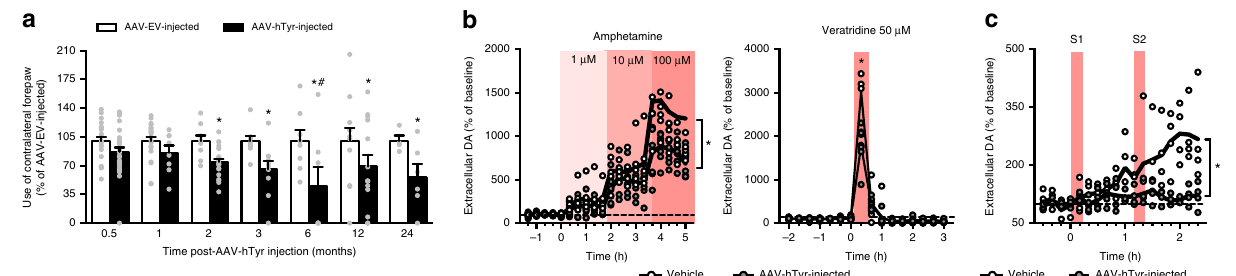
Fig. 4 Early dopaminergic dysfunction in AAV-hTyr-injected rats. a Contralateral forepaw use in AAV-hTyr- and AAV-EV-injected rats, as assessed with the cylinder test. * p ≤ 0.05, compared to AAV-EV-injected animals at the same time-point; # p < 0.05, compared to 0.5 m AAV-hTyr animals (two-way ANOVA; Student – Newman – Keuls post-hoc test). b Striatal DA release in AAV-hTyr- and vehicle-injected rats measured by microdialysis in the ipsilateral striatum following local amphetamine (left) or veratridine (right) administration by reverse-dialysis. * p < 0.05, compared to vehicle-injected animals (ANOVA for repeated measures of the DA values during the speci fi ed time periods; Tukey ’ s post-hoc test). Baseline DA concentration (fmol/fraction- 20 min): amphetamine experiments, 82.83 ± 19.16 (vehicle) vs 94.38 ± 21.82 (AAV-hTyr); veratridine experiments, 25.52 ± 4.33 (vehicle) vs 29.93 ± 6.46 (AAV-hTyr). c Striatal DA release in AAV-hTyr- and vehicle-injected rats measured by microdialysis in the ipsilateral striatum following